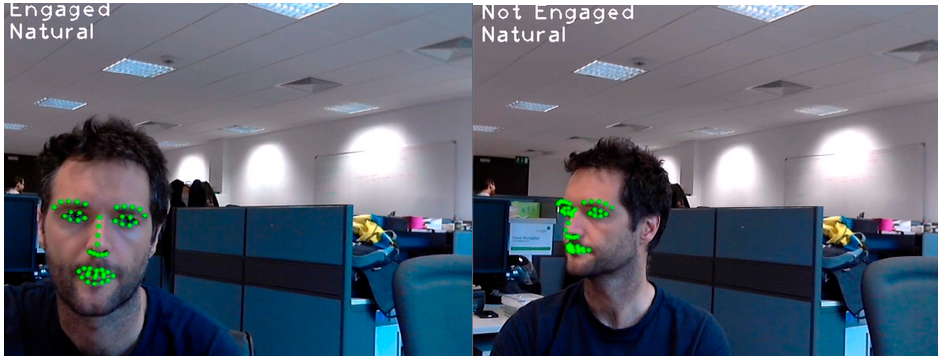
Figure 5. A user engaged with the ECA (left side) and not engaged with the ECA (right side).